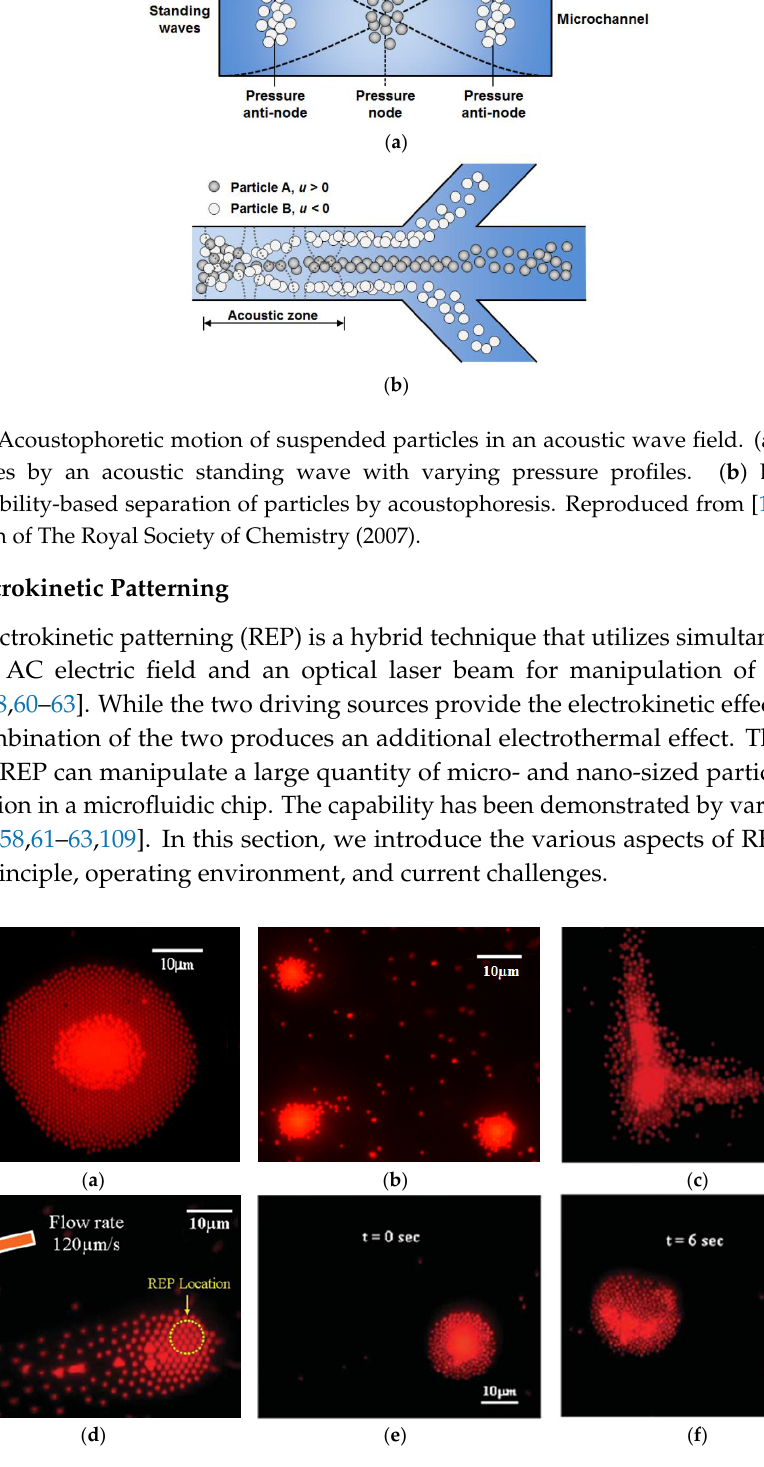
Figure 6. Manipulation of particles in a variety of forms by rapid electrokinetic patterning (REP). ( a ) REP-based aggregation; ( b ) REP-based patterning using multiple laser illuminations; ( c ) REP-based patterning by “L”-shaped illumination of a laser; ( d ) REP-based trapping in continuous flow of suspending medium; ( e , f ) REP-based translation. Reproduced from [63], with the permission of The Royal Society of Chemistry (2008).